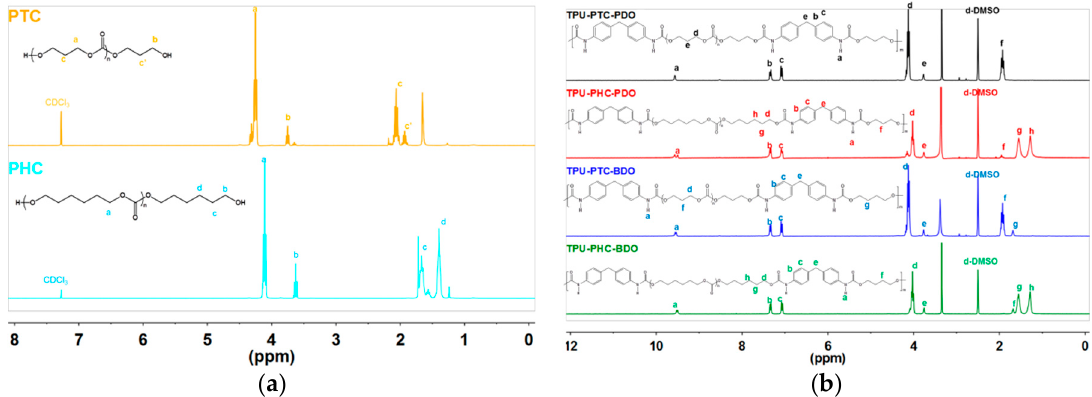
Figure 5. 1 H NMR resonance spectrum of ( a ) polyols and ( b ) TPU. 1 H NMR structural elucidation was performed to verify the chemical structure of the TPU. In Figure 5b, the peak at δ = 9.5 ppm represents the N ‒ H bond in the urethane group, the peaks at δ = 7.3 and 7.05 ppm represent the H ‐ atom on the MDI benzene ring, and the peak at δ = 3.75 ppm represents the methylene group (Ar ‒ CH 2 ‒ Ar) between the two MDI benzene rings. In the TPU ‐ PTC ‐ PDO spectrum, the peak at δ = 4.11 ppm represents the methyl group next to the urethane group ′ s carbonate group; the peak at δ = 1.92 ppm represents the remaining methyl group. In the TPU ‐ PHC ‐ PDO spectrum, the peak at δ = 4.01 ppm represents the methyl group next to the carbonate group and the urethane group; the peak at δ = 1.94 ppm represents the methyl group in the middle of the PDO, and the peaks at δ = 1.54 and 1.27 ppm represent the remaining methyl groups on the PHC. In the TPU ‐ PTC ‐ BDO spectrum, the peak at δ = 4.11 ppm represents the methyl group next to the